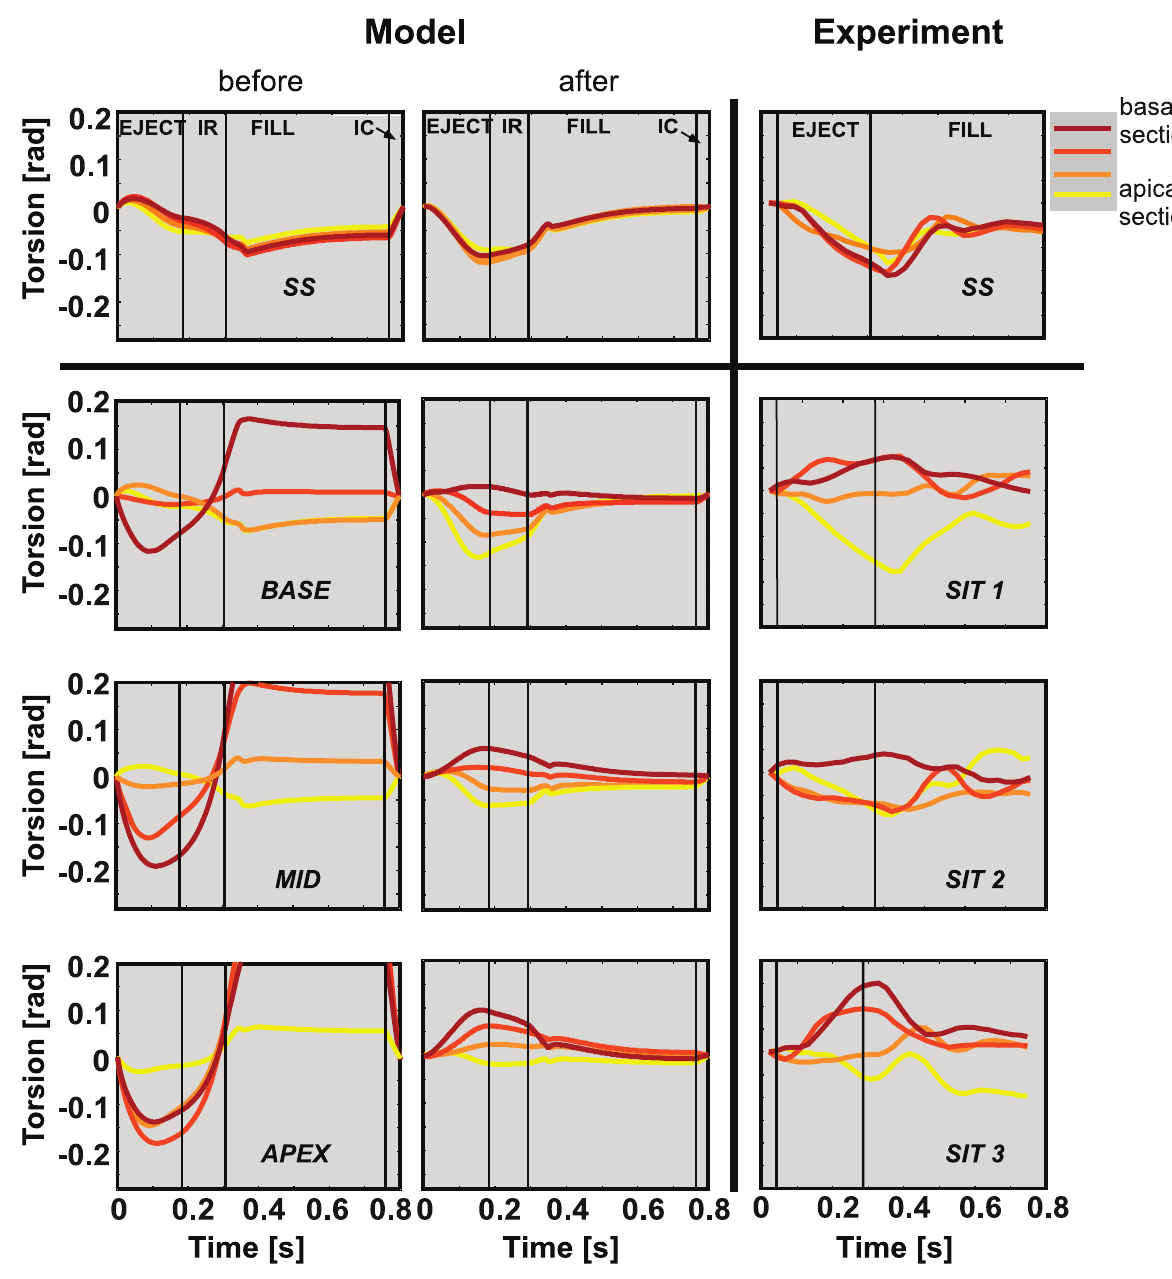
Figure 9. Torsion [rad] during a cardiac cycle. Results are presented from simulation SS (upper left), an SS subject (upper right), 3 SIT simulations (bottom left), and 3 SIT subjects (bottom right). Model results are shown before and after reorientation. Torsion was determined in four sections between apex and base. EJECT =ejection phase; IR =isovolumic relaxation phase; FILL =filling phase; IC =isovolumic contraction phase.